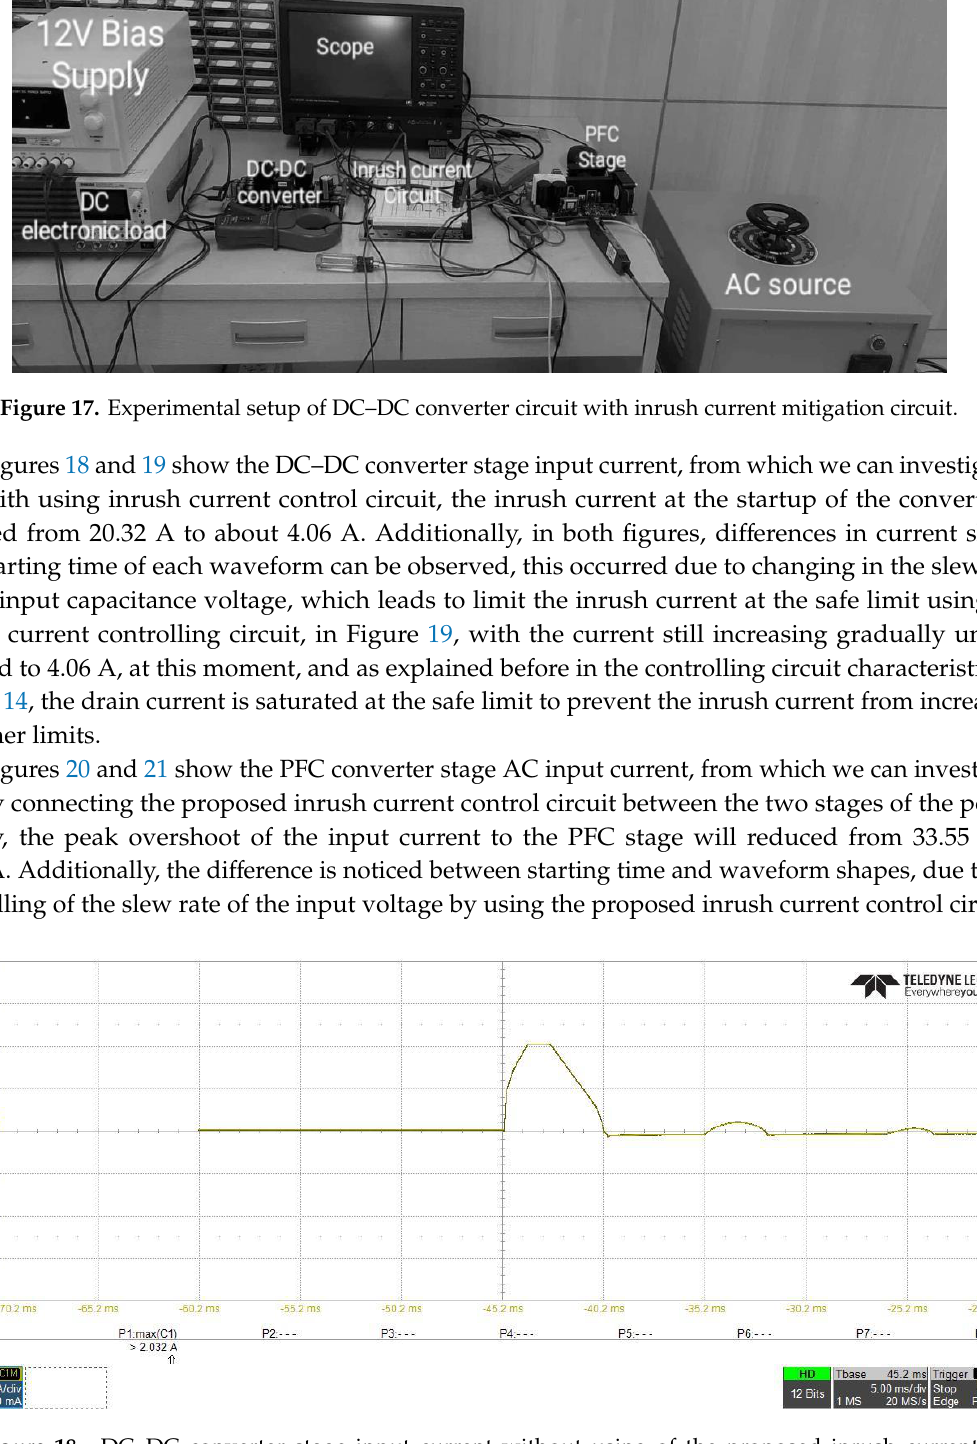
Figure 18. DC – DC converter stage input current without using of the proposed inrush current Figure 18. DC–DC converter stage input current without using of the proposed inrush current mitigation circuit. mitigation